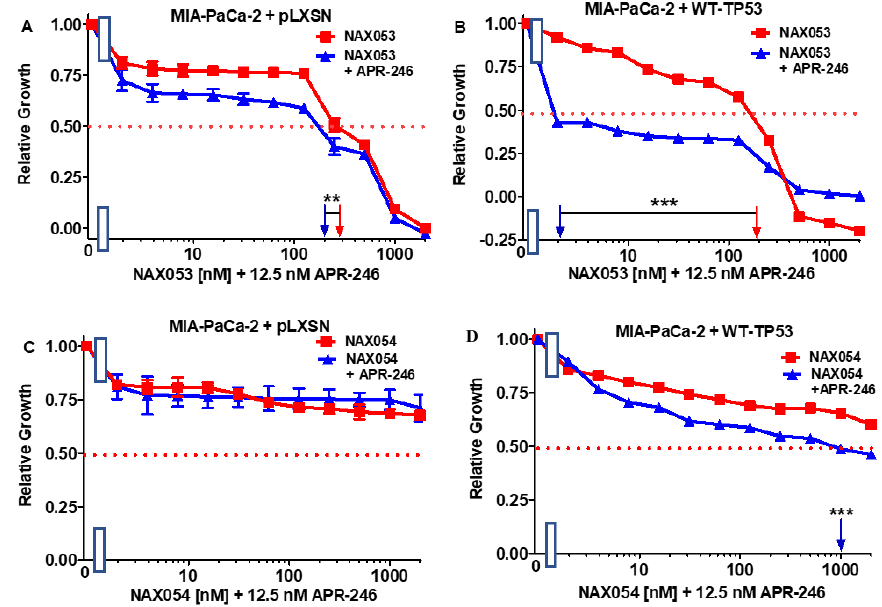
Figure 6. APR ‐ 246 enhances the responses of NAX053 in MIA ‐ PaCa ‐ 2 when WT ‐ TP53 is present, while APR ‐ 236 has less effects on the responses of NAX054 on MIA ‐ PaCa ‐ 2 cells in the presence of WT ‐ TP53. Panel ( A ) MIA ‐ PaCa ‐ 2 + pLXSN cells treated with different concentrations of NAX053 (red squares) or with different concentrations of NAX053 and a low dose of APR ‐ 246 (blue triangles). Panel ( B ) MIA ‐ PaCa ‐ 2 + WT ‐ TP53 cells treated with different concentrations of NAX053 (red squares) or with different concentrations of NAX053 and a low dose of APR ‐ 246 (blue triangles). Panel ( C ) MIA ‐ PaCa ‐ 2 + pLXSN cells treated with different concentration of NAX054 (red squares) or with different concentrations of NAX054 and a low dose of APR ‐ 246 (blue triangles). Panel ( D ) MI ‐ PaCa ‐ 2 + WT ‐ TP53 cells treated with different concentrations of NAX054 (red squares) or with different concentrations of NAX054 and a low dose of APR ‐ 246 (blue triangles). The measurements were repeated 4 times, and similar results were observed. *** = p < 0.0001, ** = p < 0.005. Previously we have observed that NAX054 did not have any significant effects on MIA ‐ PaCa ‐ 2 cells [77,78]. Likewise, NAX054 did not have effects on MIA ‐ PaCa ‐ 2 + pLXSN in the presence of ABR ‐ 246. However, in MIA ‐ PaCa ‐ 2 + WT ‐ TP53 cells, APR ‐ 246 reduced the IC 50 to NAX054 at least two ‐ fold (Figure 6C,D). The low dose of APR ‐ 246 had an effect on the sensitivity of MIA ‐ PaCa ‐ 2 + pLXSN cells to NAX060 as the IC 50 decreased two ‐ fold from 800 to 400 nM (Figure 7, Panel A), but it had a more significant effect on the sensitivity of MIA ‐ PaCa ‐ 2 + WT ‐ TP53 cells to NAX060 as the IC 50 decreased 110 ‐ fold from 220 to 2 nM (Figure 7B).